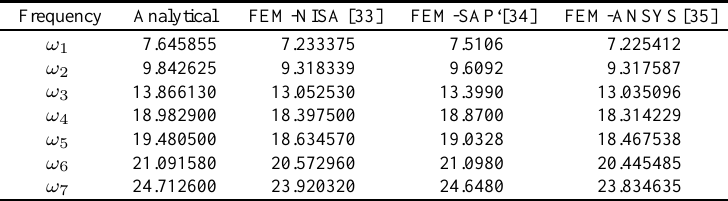
Table 4 Comparison of normalized frequencies between analytical and FEM solution for panels with b/a = 2, R/a = 10, a/h =